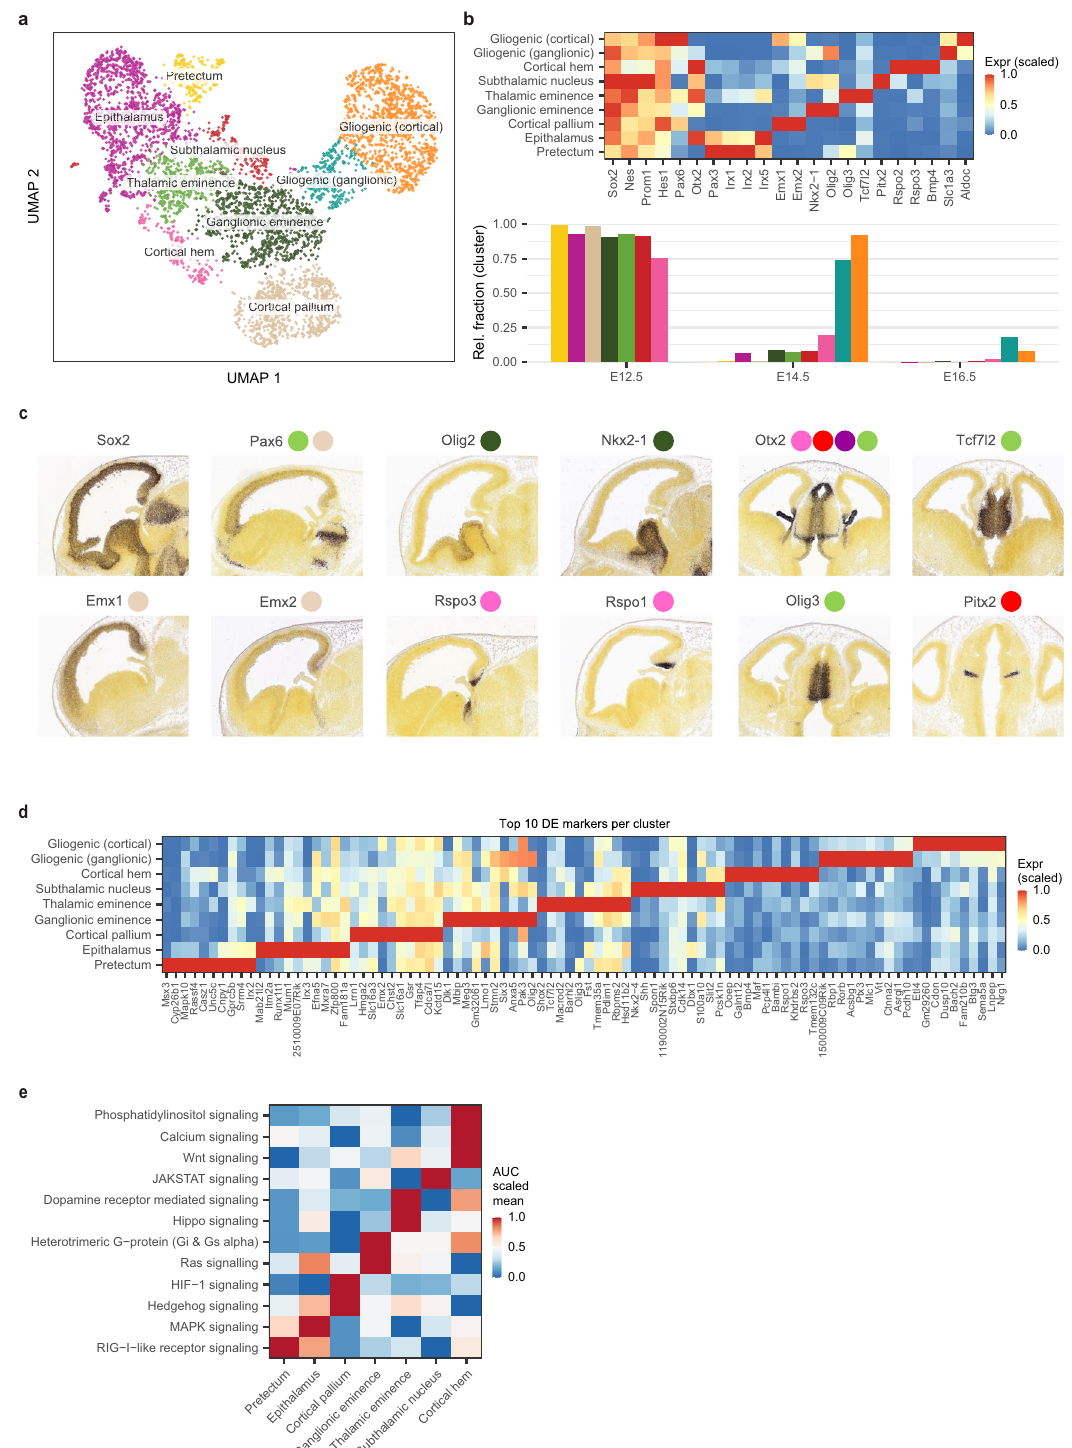
Fig. 3 Regional distribution of radial precursors during the early embryonic stage. a UMAP plot with Leiden clustering of the embryonic RG cells showing the main clusters/cell-subtypes identi fi ed. Each dot represents a single cell and the colours correspond to the different clusters. b Top: heatmap of the main marker genes used to annotate the clusters in ( a ). Shown on the bottom panel is a bar plot showing the normalized relative fraction of the distinct clusters grouped by timepoint. Colours correspond to the clusters in ( a ). c In-situ hybridization staining of sagittal (columns #1-4) and transverse (columns #5, 6) slices from E13.5 mouse embryos, showing the expression of some of the markers used to identify the clusters in panel ( a ). In-situ hybridization images were obtained from the Allen Brain Map: Developing Mouse Brain Atlas. The coloured circles correspond to the clusters in panel ( a ). d Heatmap of the top 10 DE marker genes identi fi ed per cluster from analyzing the clusters in panel ( a ). Colour scale indicates the scaled mean expression in each cluster. e A heatmap showing the signi fi cantly enriched signaling pathways in each of the regional embryonic RG subtypes. Colour scale indicates the scaled mean AUC score. Source data are provided as a Source Data fi le. Abbreviations as in Fig.